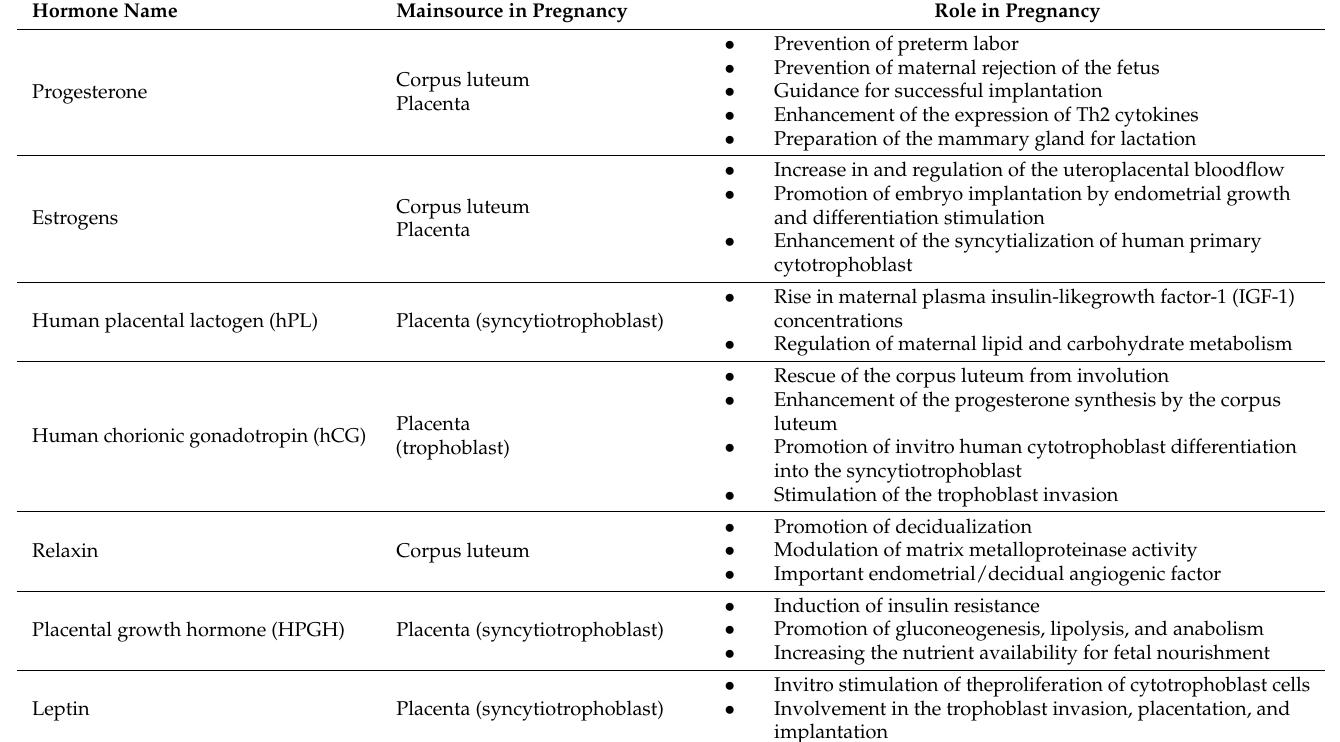
Table 1. Fundamental hormones of pregnancy and their role